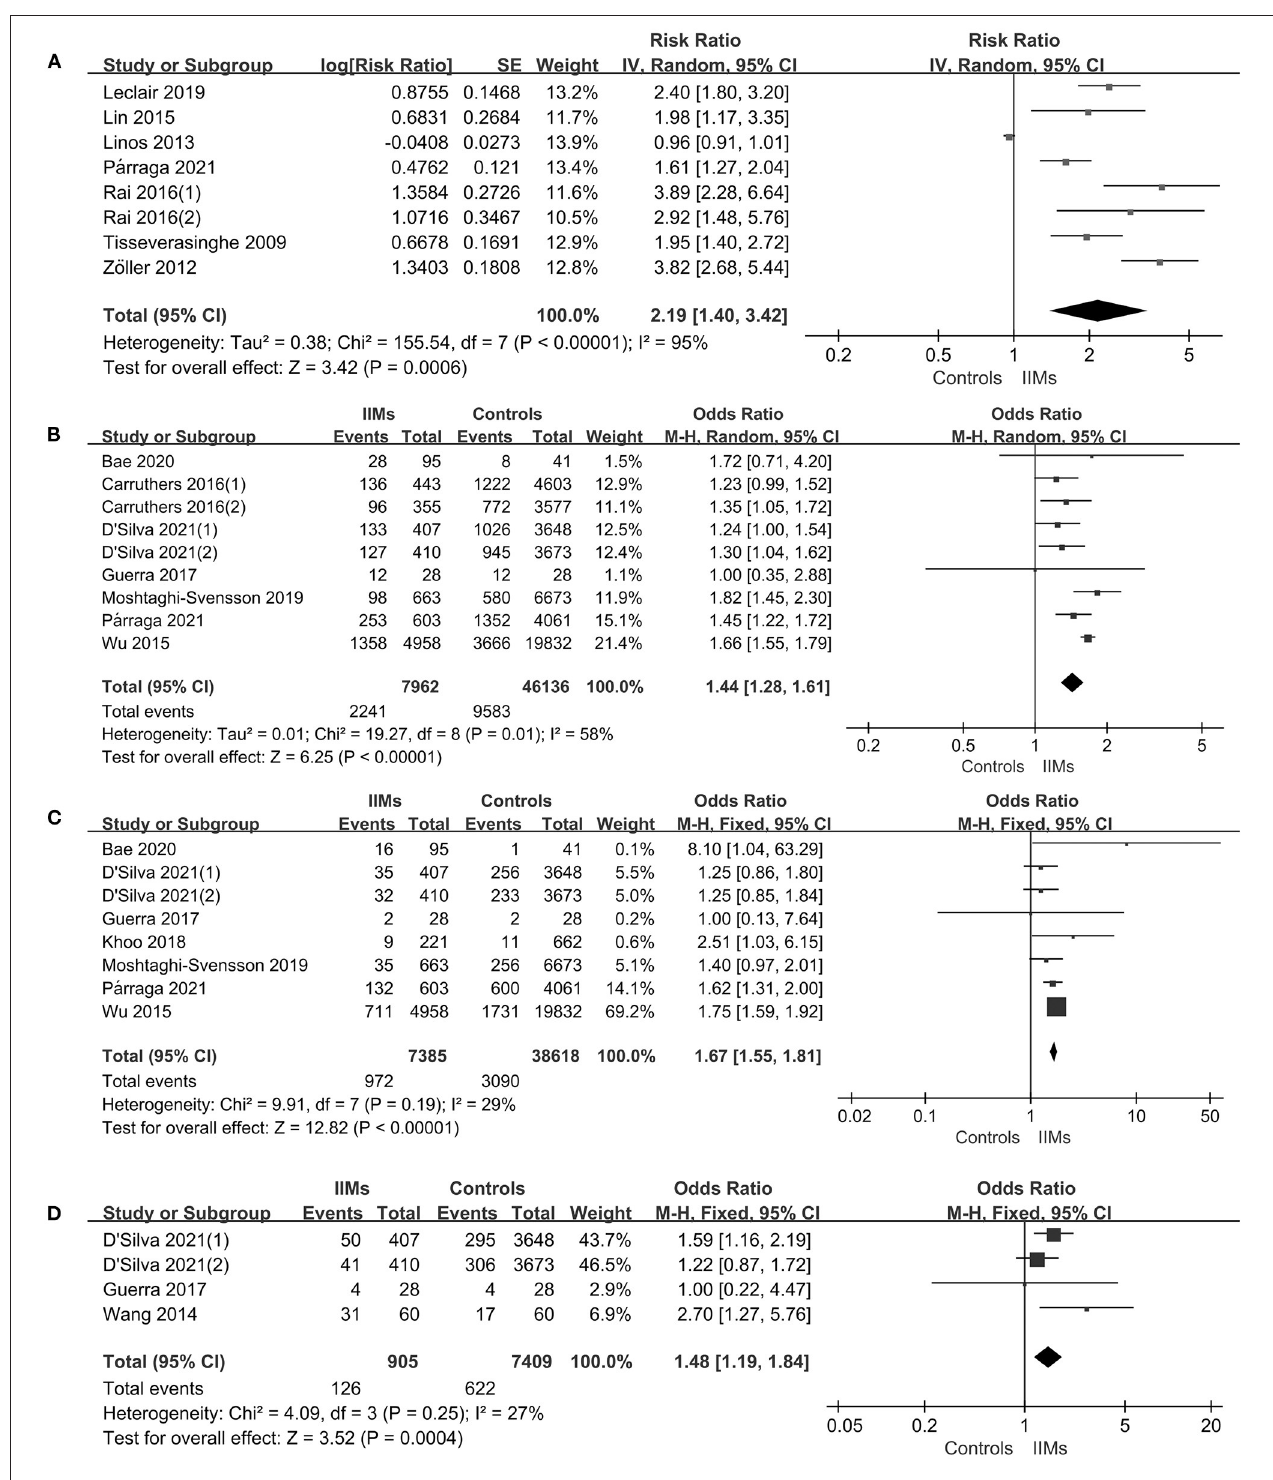
FIGURE 3 | (A) Comparison of CHD risk between IIMs patients and controls. (B) Comparison the prevalence of hypertension between IIMs patients and controls. (C) Comparison of the prevalence of diabetes mellitus risk between IIMs patients and controls. (D) Comparison the prevalence of dyslipidemia risk between IIMs patients and controls. IIMs, idiopathic inflammatory myopathies; CHD, coronary heart disease.